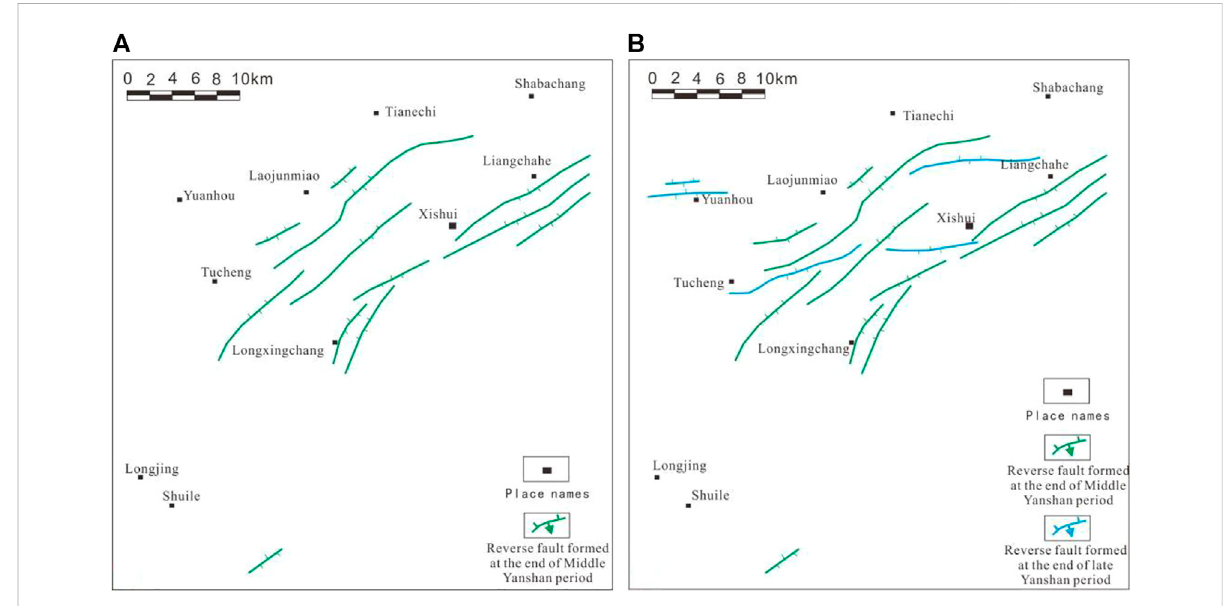
FIGURE 8 Evolution of paleo-faults in Lintanchang area ( (A) : end of Middle Yanshanian, (B) end of late